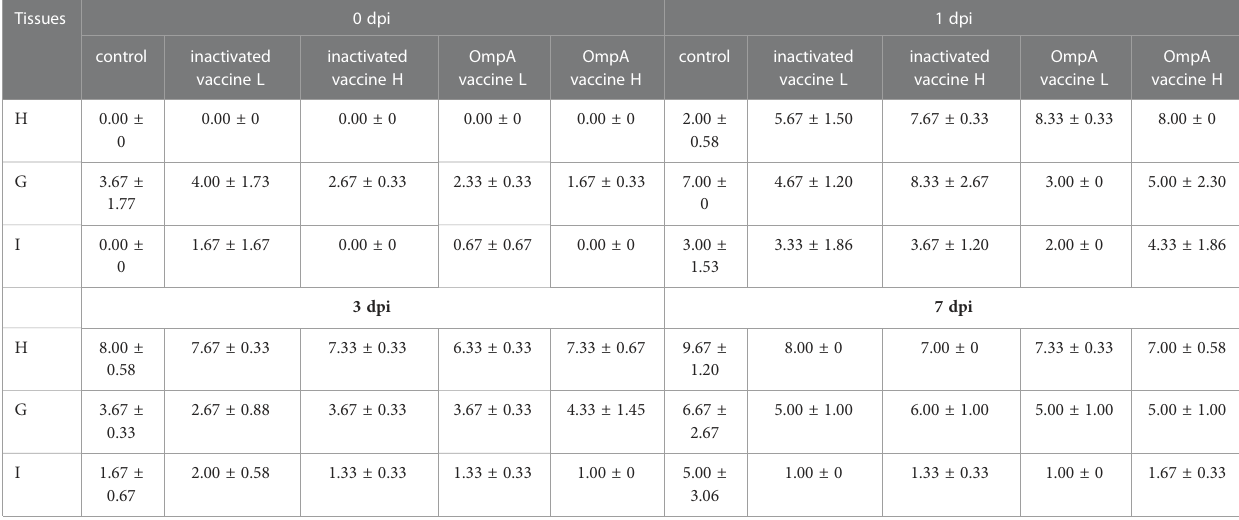
TABLE 2 Histopathological change scores in all study groups.